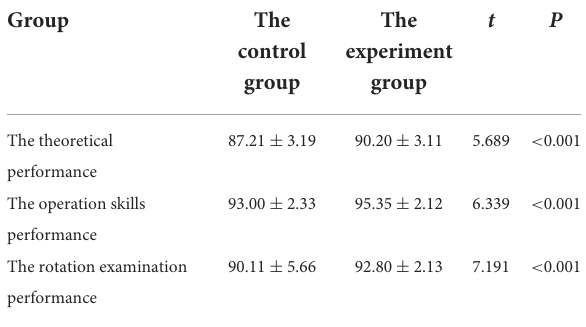
TABLE 2 The comparison of the rotation examination performance between the two groups of intern nursing students.